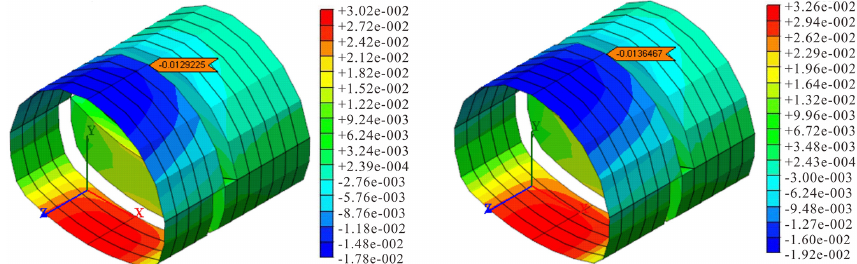
Figure 15. Vertical displacement nephogram of the vault with the lower bench excavation (mm).